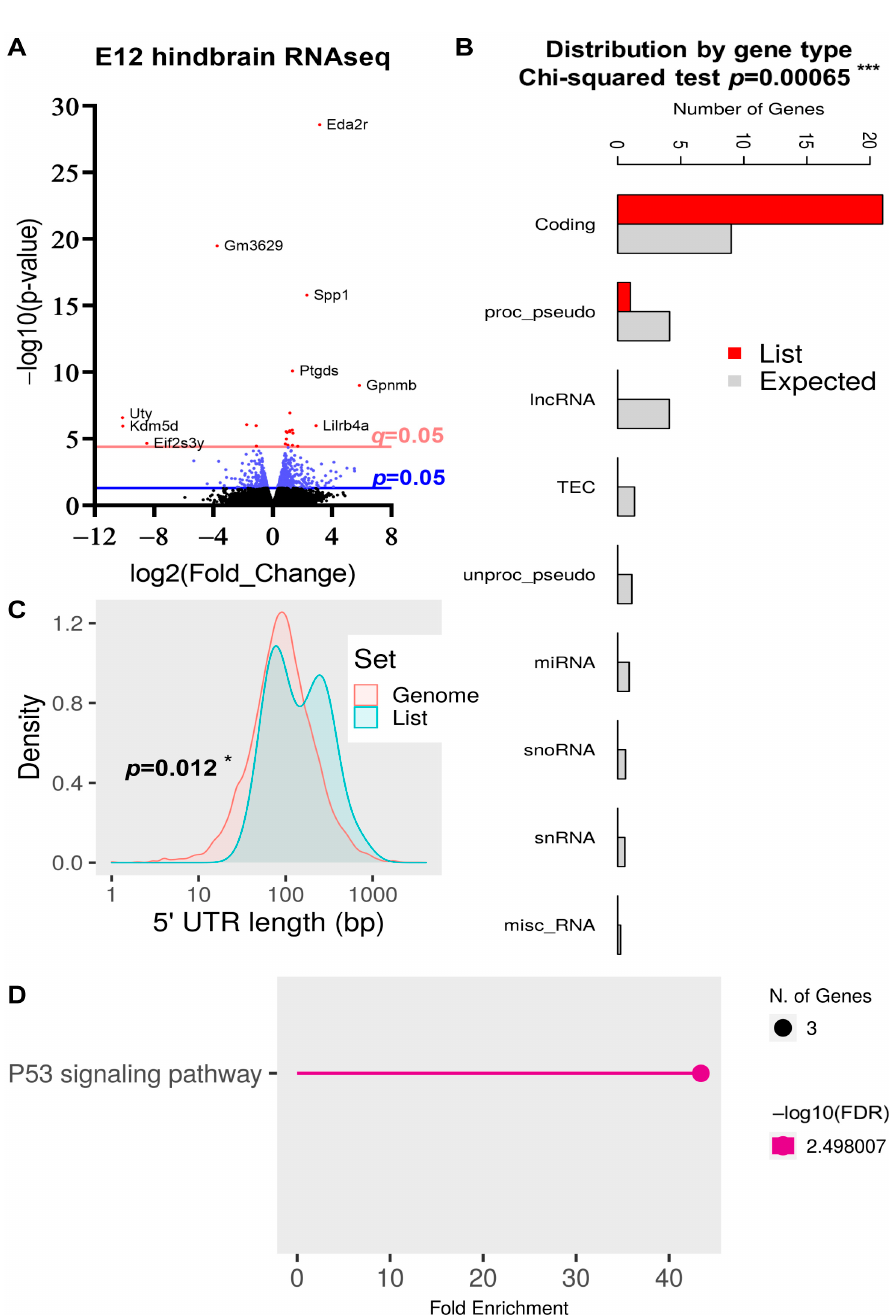
Figure 7. Quantifiable expressional changes in the hindbrain between control and Rbm8a cKO mice at E12. ( A ) The volcano plot of all transcripts detected in the brains of control and Rbm8a cKO mice at E12. A total of 847 genes were expressed differently with p < 0.05, 281 genes were expressed differently with p < 0.01, and 25 genes were expressed differently with q < 0.05. A total of 23 DEGs with significant q -values were up- or downregulated at least twofold. The p and q cutoffs (=0.05) are shown. ( B ) The distribution of DEGs is significantly enriched in protein-coding genes. ***, p < 0.001. ( C ) DEGs at the E12 hindbrain show significant changes in the length of 5 ′ UTR. *, p < 0.05. ( D ) KEGG pathway analysis of DEGs of E12 hindbrains.